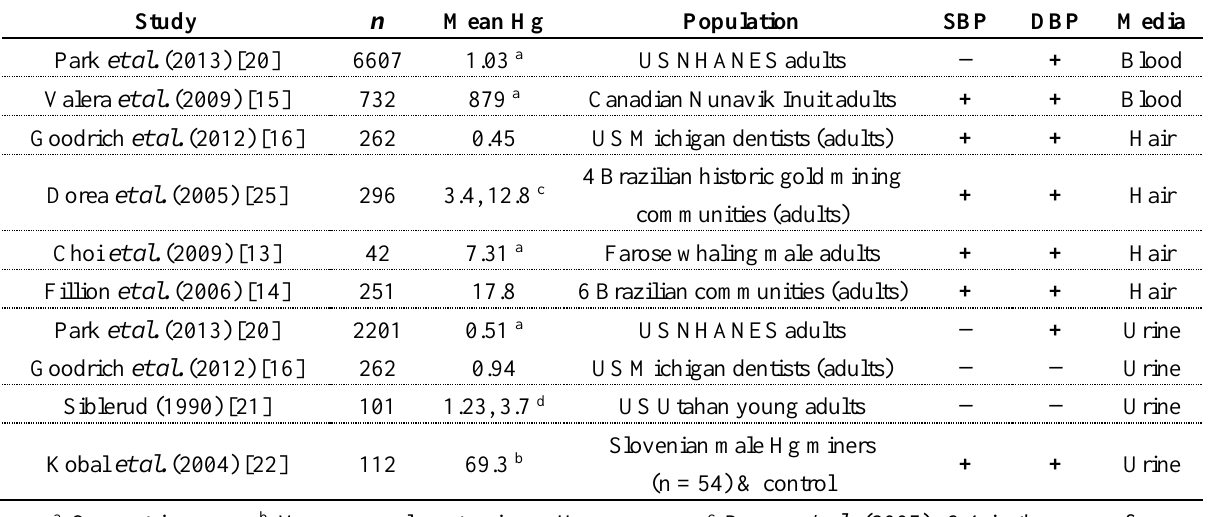
Table 1. Summary of Hg biomarkers (blood, hair, urine) and associations (indicated as either positive or negative) between Hg biomarkers and SBP and DBP from other